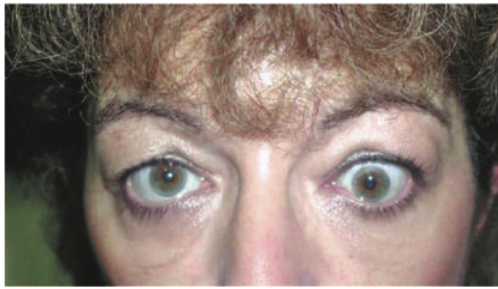
Figure 2: Preoperative photograph of patient with unilateral (left) Graves ophthalmopathy.